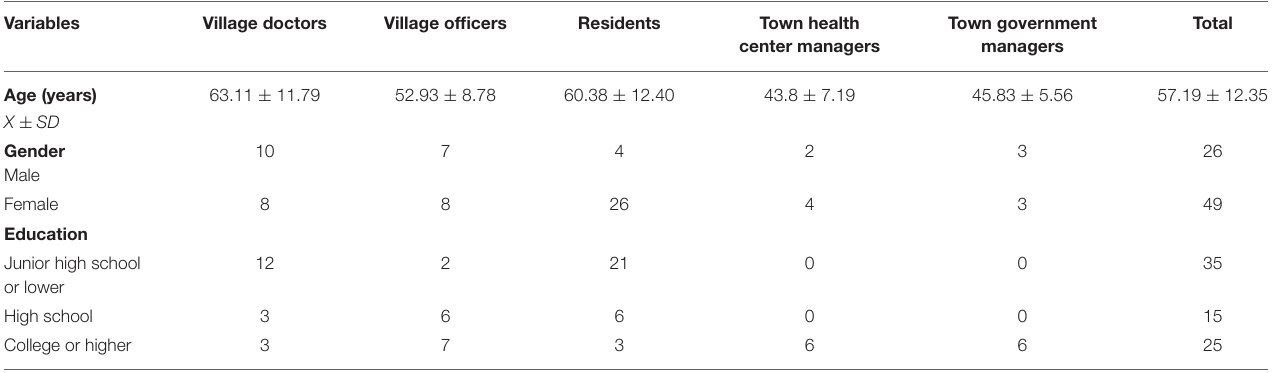
TABLE 2 | Basic sociological characteristics of respondents.